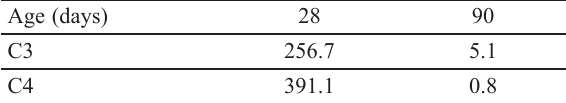
Fig. 12. Chloride ion diffusion vs. surface density of the aggregate ( Sv ) Table 11. Standard deviation of chloride ion diffusion